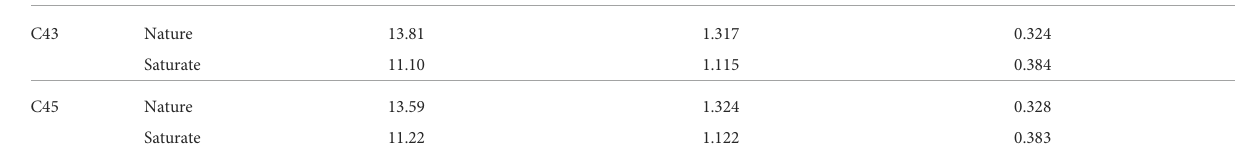
Number Water-contained state Average uniaxial compressive